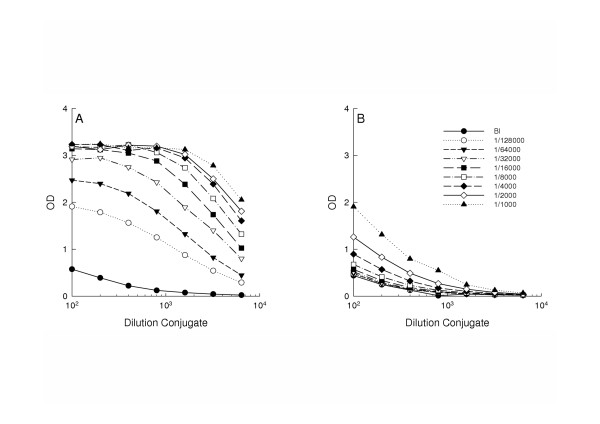
Selection of capture and conjugating antibody. 96-wells plates were coated with either rabbit anti-mouse thrombin antibodies (Panel A) or rabbit anti-rat antithrombin antibodies (Panel B) prior to incubation with two-fold serial dilutions of in vitro TAT-complexes. Plates coated with rabbit α-AT antibodies were subsequently incubated with serial dilutions of DIG-conjugated rabbit α-thrombin antibodies, whereas plates coated with rabbit α-thrombin antibodies were incubated with serial dilutions of DIG-conjugated rabbit α-AT antibodies.